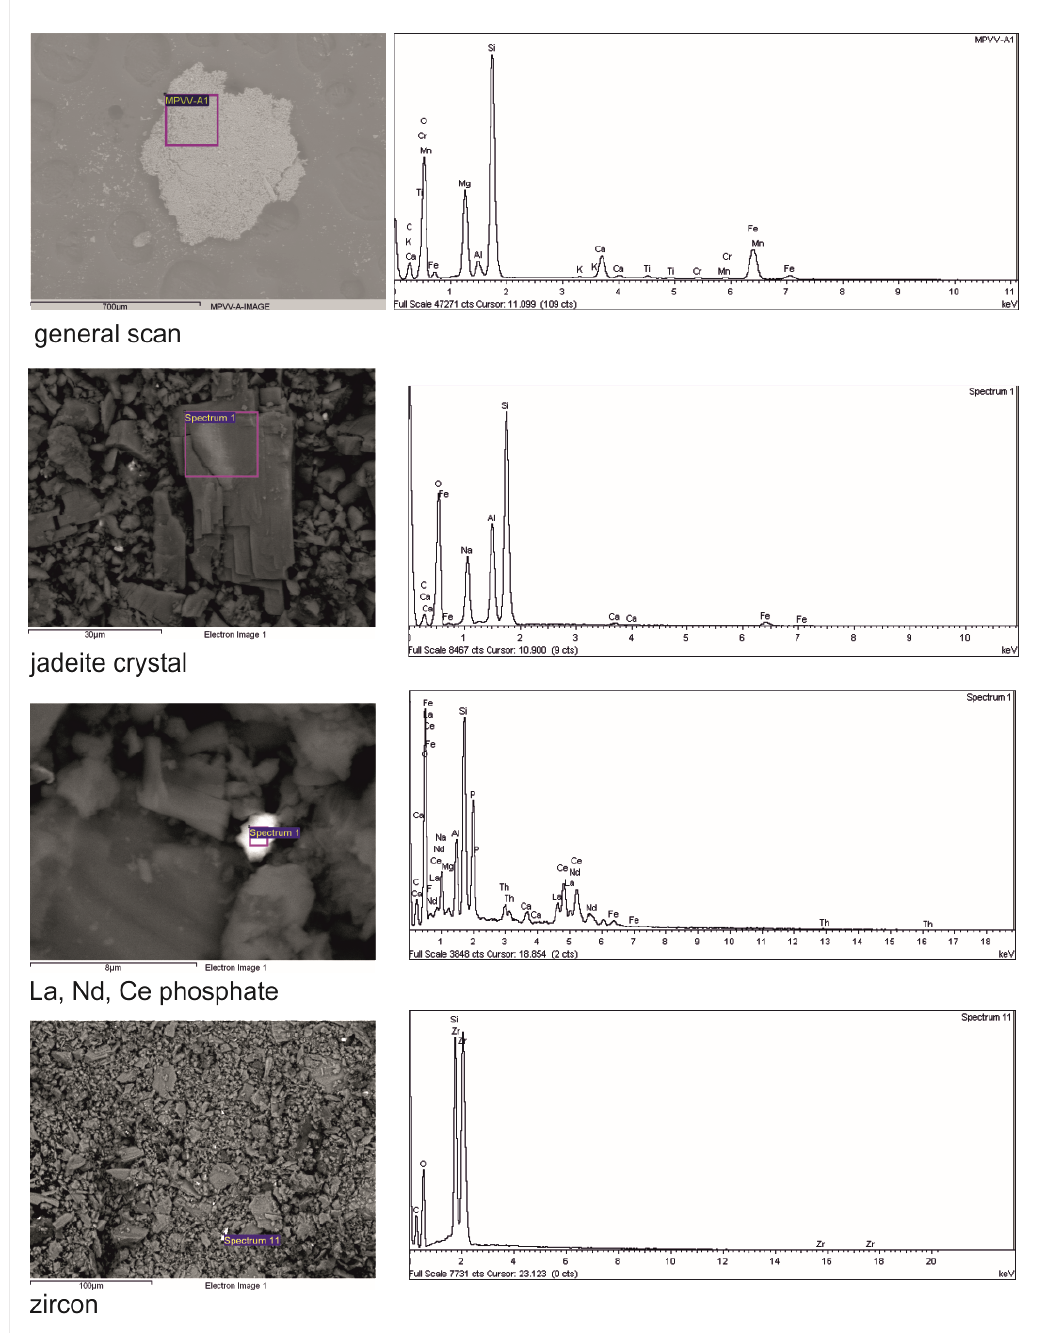
Figure 10. Different trace minerals detected by SEM-EDX in the Vilapedre axe (MPVV). Produced by A